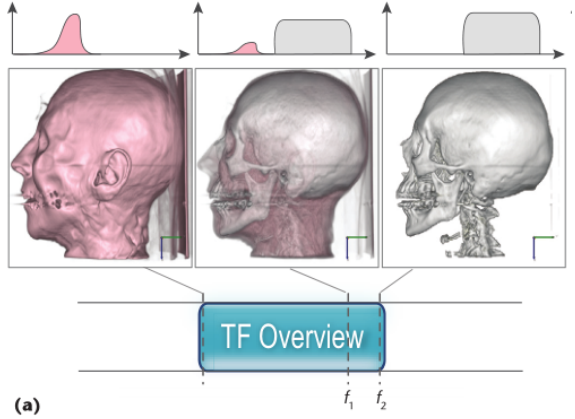
Figure 29. Akiba et al. show the AniVis animation tool displaying MRI scan data. By blending the two layers of data together, a new layer of information is revealed (middle image) [53]. Image courtesy of Akiba et al.